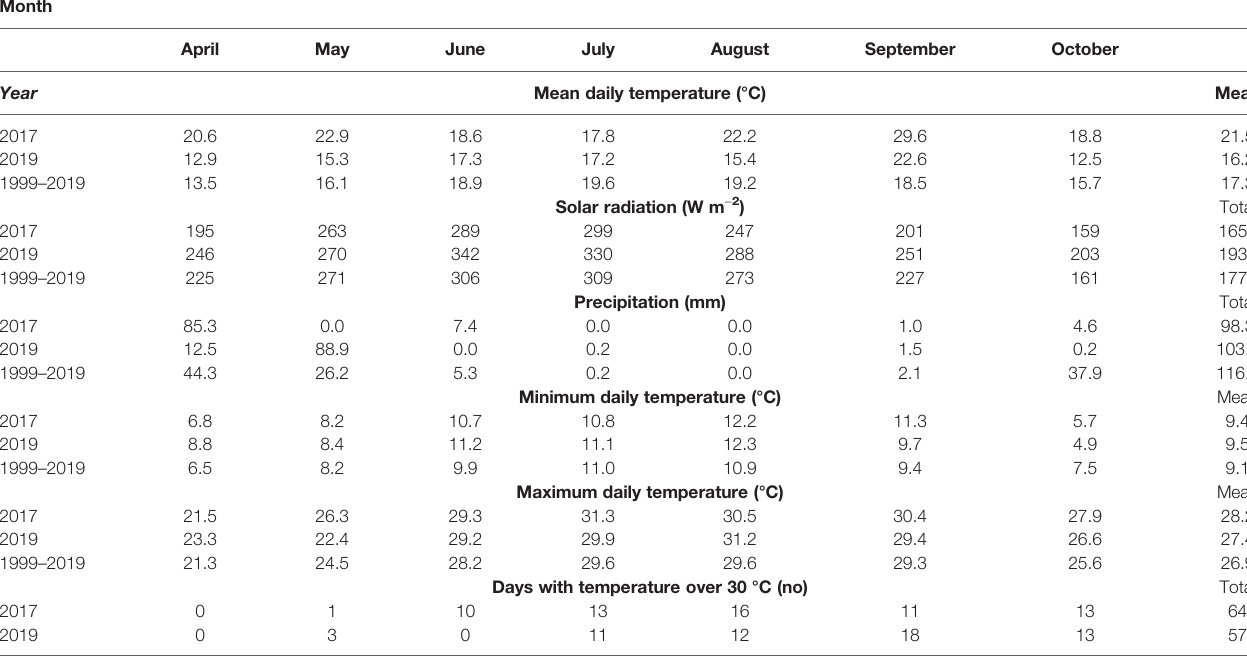
TABLE 1 | Weather conditions during the growing seasons of 2017, 2019 and the average for the same period in the last 20 years (1999 – 2019).